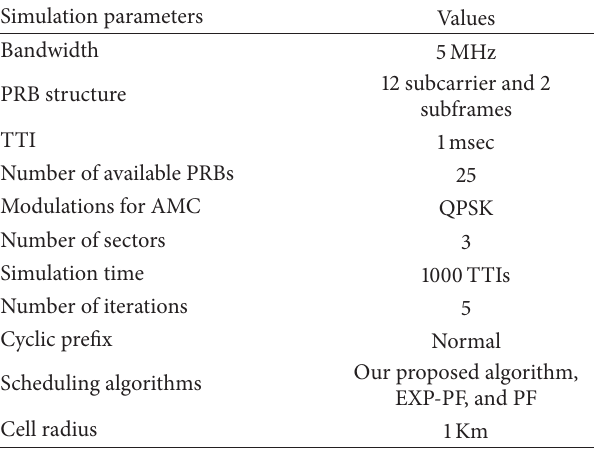
Table 1: Simulation